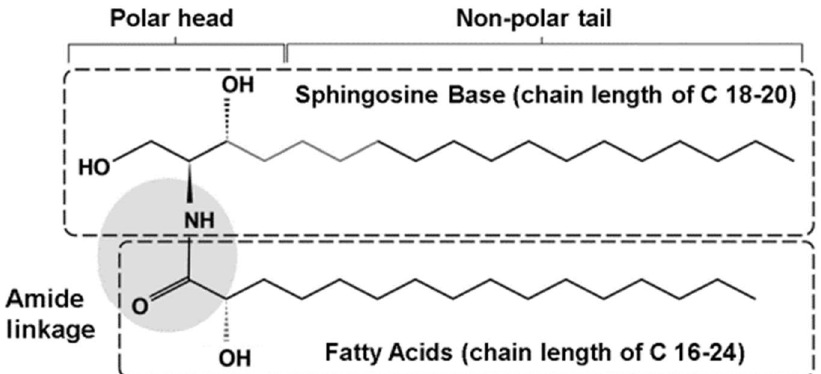
Figure 2. The chemical structure of ceramides. A typical ceramide molecule is composed of long-chain shingosine bases (usually 18 to 20 carbons long) with amide-linked fatty acids (usually 16 to 24 carbons long). The shingonid base contains a polar head and a non-polar tail. In some cases, the fatty acids can be 16 to 36 carbons long [45,46]. The sphinosine base may consist of dihydrosphingosine, sphingosine, phytosphingosine, or hydroxy sphingosine. The fatty acid may be a non-hydroxyl fatty acid, an α-hydroxyl fatty acid, or an esterified ώ-hydroxyl fatty acid. Re-drawn with permission [46].